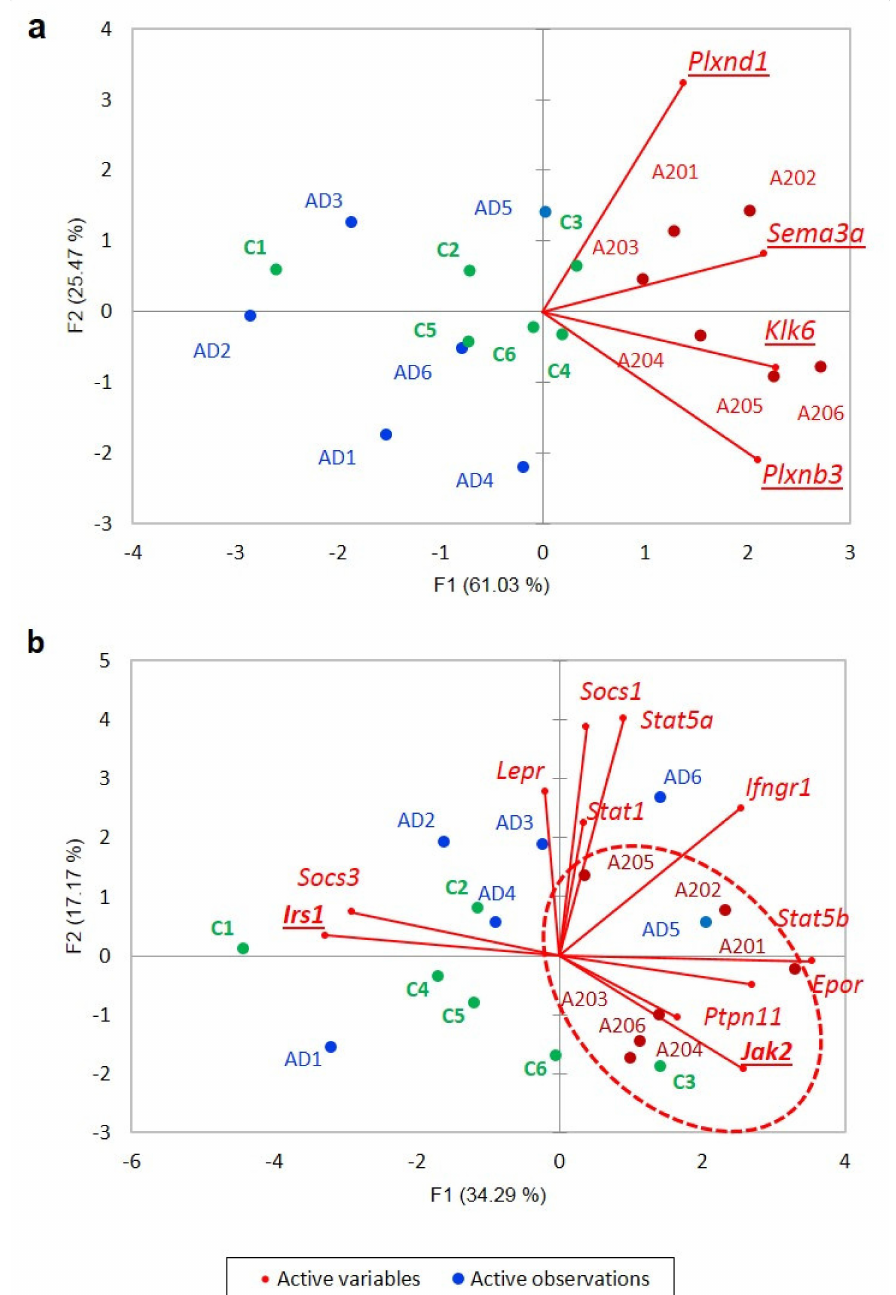
Figure 11. ( a ) “Semaphorin-plexin signaling” GO DEG set (4 genes); H0: random distribution of samples across 2 plot halves, p -value < 0.00065 (binomial test); ( b ) JAK/STAT gene projection inferred from string-db.org seeded by Jak2, Irs1 DEGs; H0: random distribution of samples across 2 plot halves, p -value < 0.0045 (binomial test). Underlined gene names signify DEGs. Encircled is A20